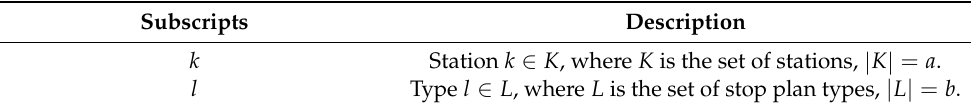
Table 3. General